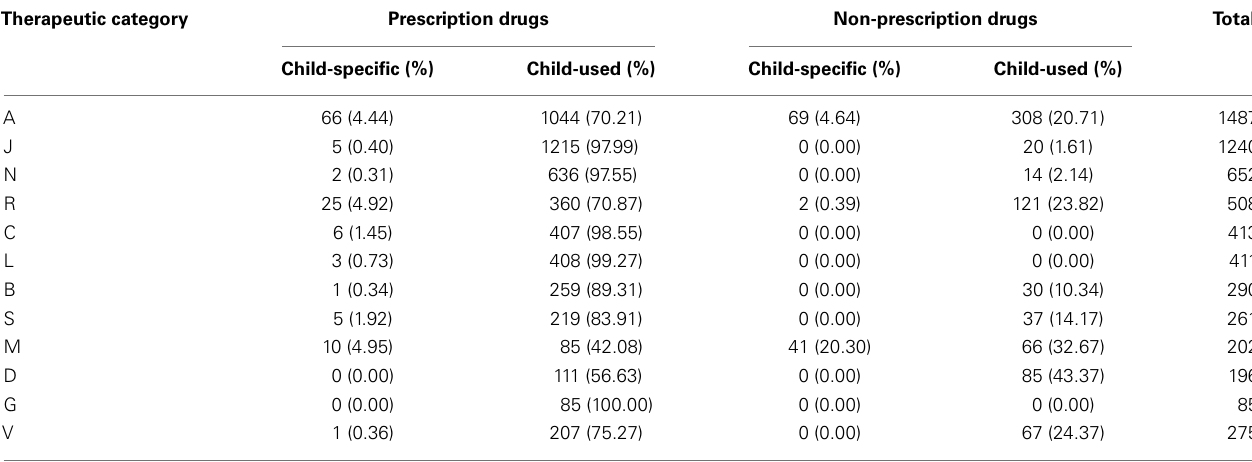
Table 3 |Therapeutic category of pediatric medicines .